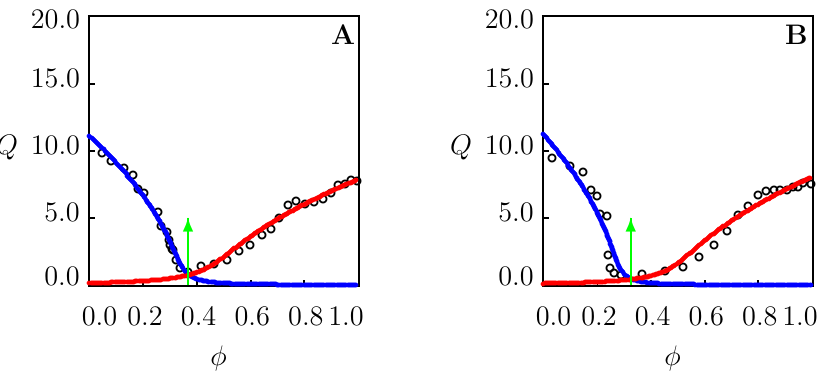
Figure 4. Equilibrium degree of swelling Q versus volume fraction φ of methanol ( A ) and ethanol ( B ). Circles: experimental data [30] on PNIPAAm microgel in water/alcohol mixtures at tempera- ture T = 12.5 ◦ C. Solid lines: results of numerical analysis. Arrows indicate the volume phase transition points.